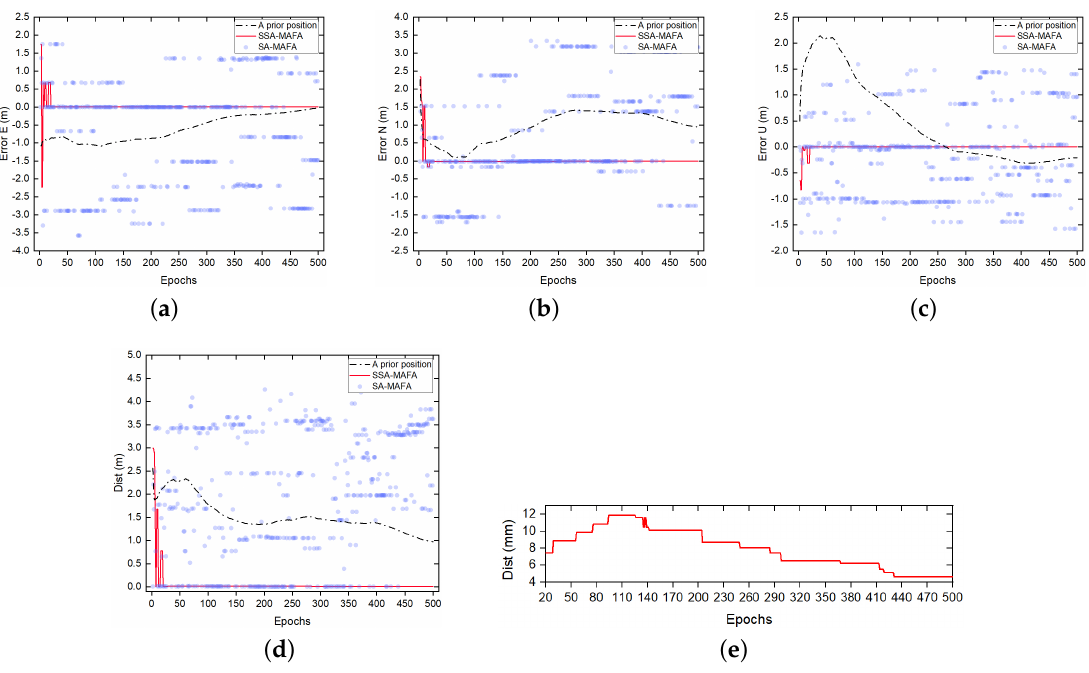
Figure 12. The error results (in meters) of searching in x , y , z domain by using SSA-MAFA and SA-MAFA. ( a ) The errors in East direction. ( b ) The errors in North direction. ( c ) The errors in Up direction. ( d ) The errors in both East, North and Up direction, where Dist = convergence result by using SSA-MAFA method from epoch 20 to epoch 500.